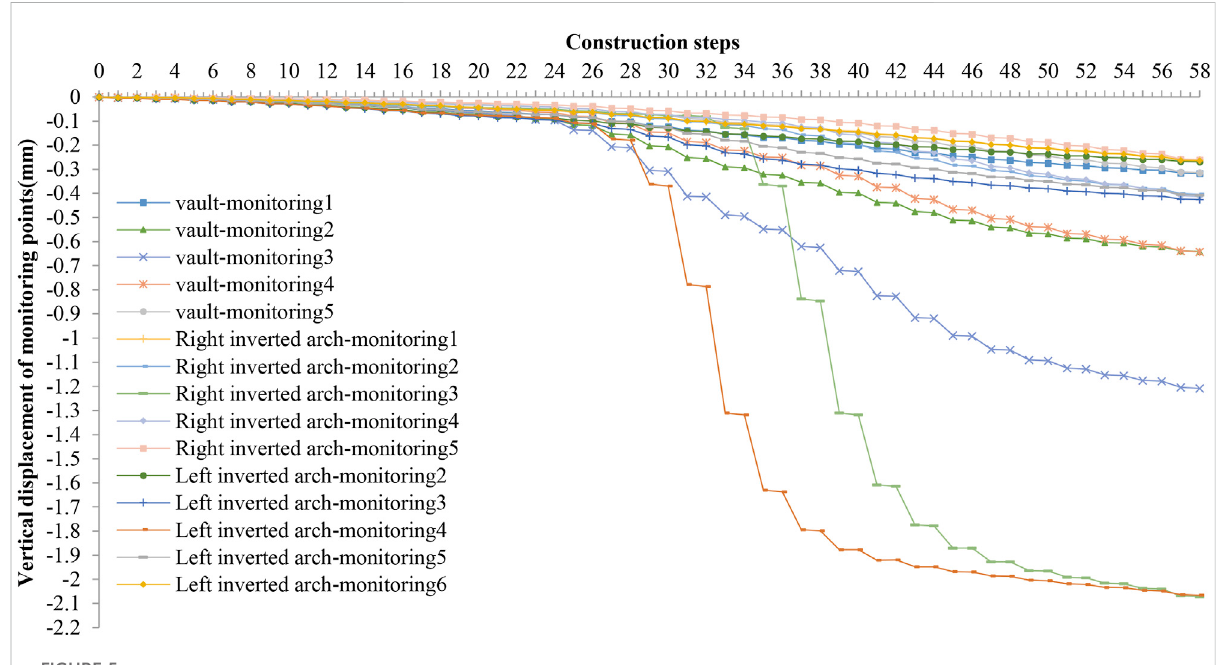
FIGURE 5 Vertical displacement of monitoring points of the left tunnel.